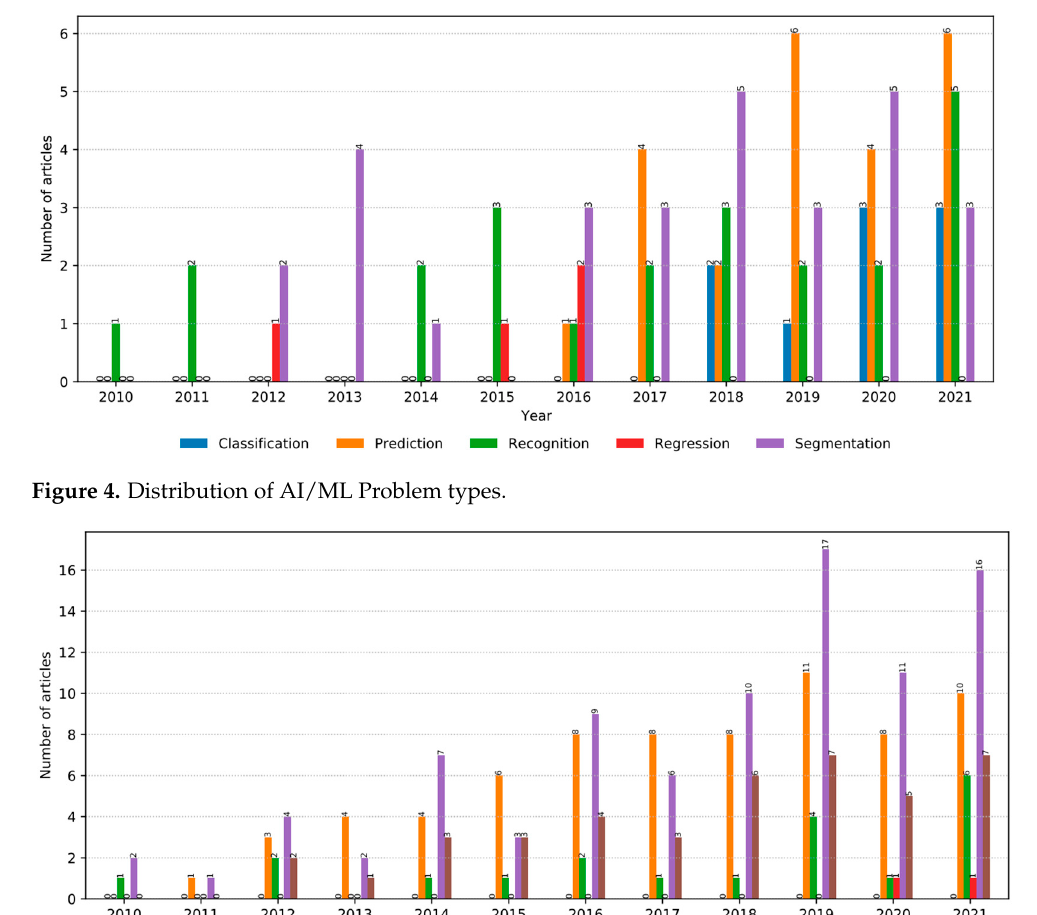
Figure 5. Distribution of eye parts affected by IRD.